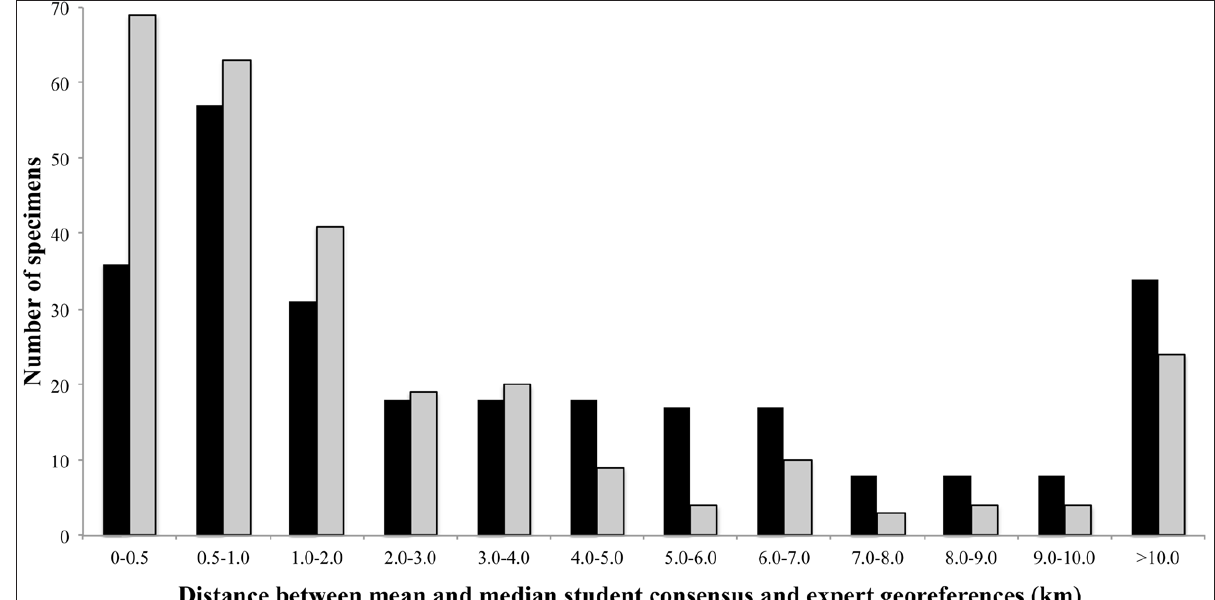
Figure 3: Distribution of the distance between mean (black bars) and median (gray bars) consensus of student replicate georeferences from the expert points in the plant experiment at Florida State University with outliers